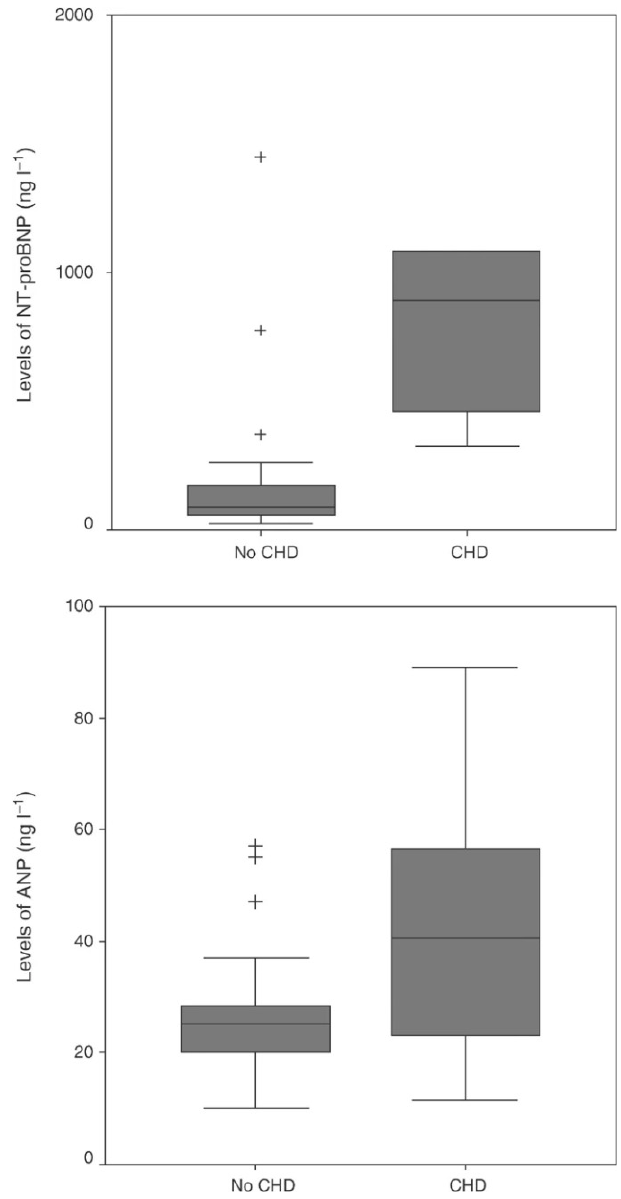
Figure 10. Difference in mean NT-proBNP (top box) and ANP (bottom box) levels between patients with carcinoid heart disease (CHD) and without (No CHD). Values beyond the lines are considered outliers (+) [86].